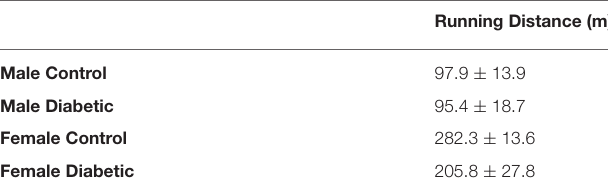
TABLE 1 | Absolute treadmill running distance at month 3 post-diabetes